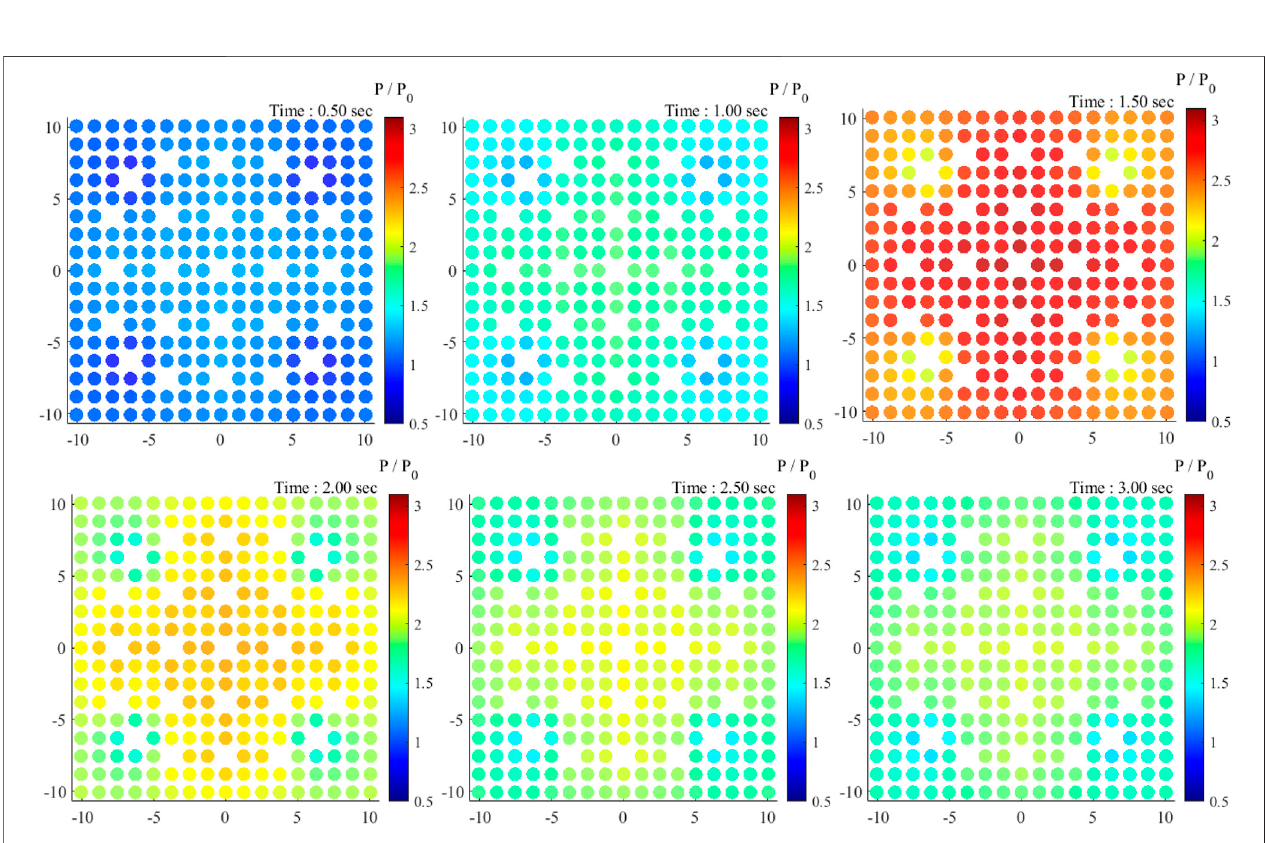
FIGURE 6 | Time-dependent fuel average temperature (A) and coolant average temperature (B)